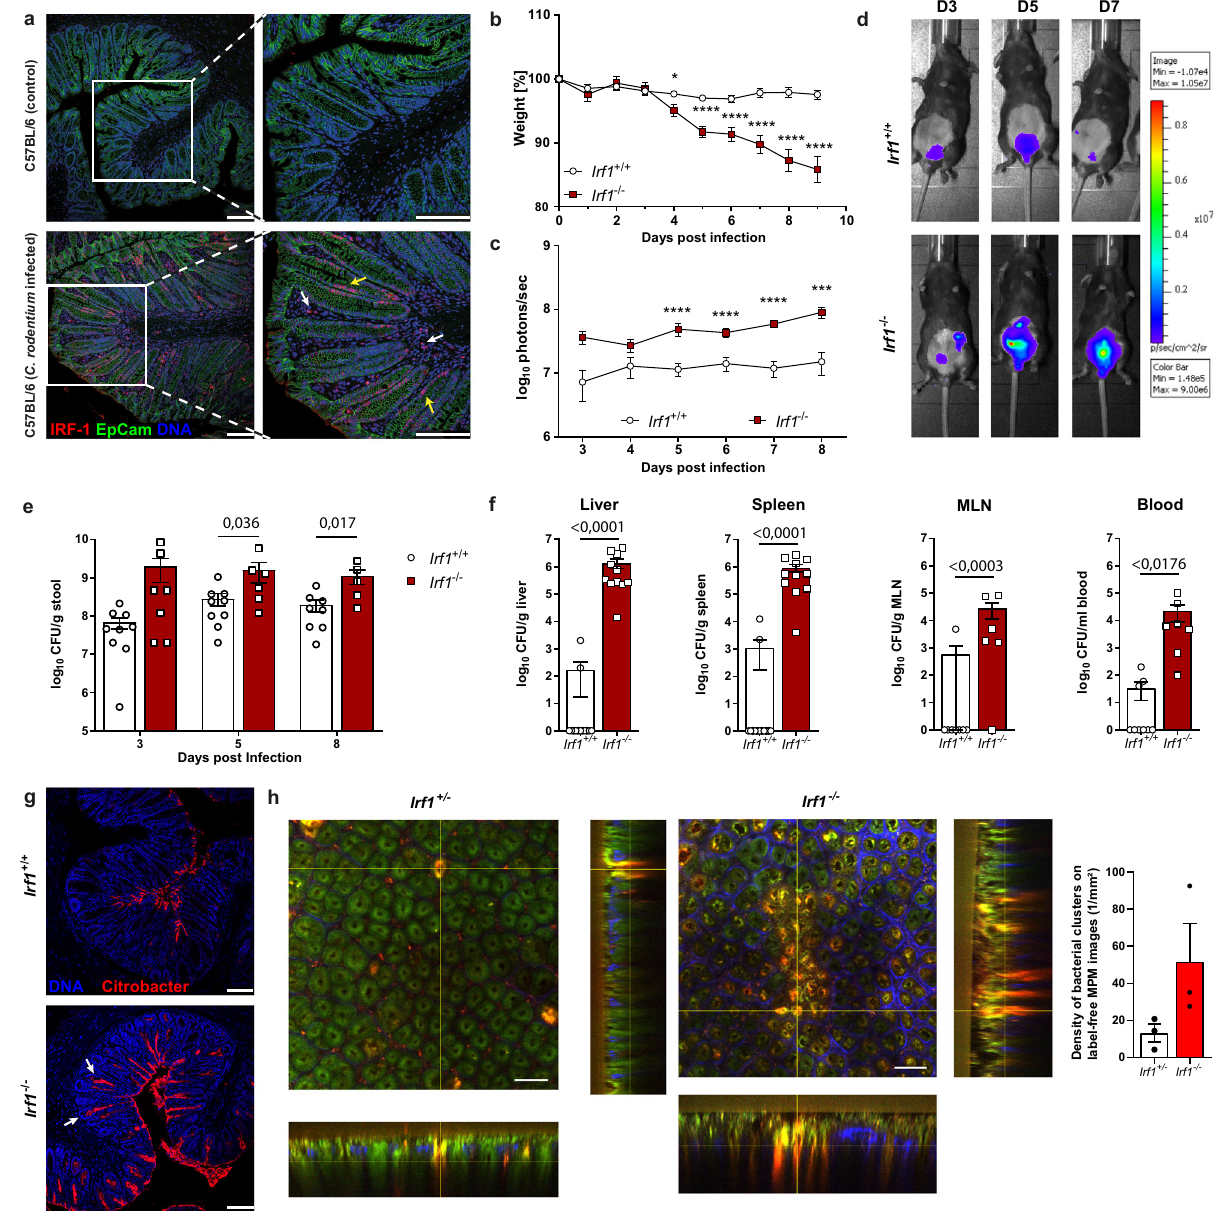
Fig. 1 | IRF-1 expression is essential to mount ef fi cient C. rodentium directed immunity. a Colonic cross sections of uninfected or C. rodentium (9 dpi) infected C57BL/6 mice stained with anti-IRF-1 (red), anti-Ep-CAM (green), and DAPI (blue) and analyzed by confocal microscopy (epithelium: yellow arrow heads; lamina propria cells: white arrow heads). Scale bars represent 100 µ m. b – g Irf1 +/+ and Irf1 – / – mice were infected orally with 4 × 10 9 CFU of C. rodentium . b Weights of infected micewererecorded dailyandplottedaspercentageofbaseline( Irf1 +/+ : n =19, Irf1 – / – n =18).Day4pvalue: 0,0172;pvalues day5-day9: <0.0001. c , d Bacterialloads were measured via in vivo imaging ( n =15/group). Day 8 p value: 0.0008; p values day5 – day7: <0.0001. e Fecal bacterial loads (CFU/g stool) on 3, 5 and 8 dpi. ( Irf1 +/+ : n =9, Irf1 – / – n =7). f Dissemination of C. rodentium to livers ( Irf1 +/+ : n =13, Irf1 – /